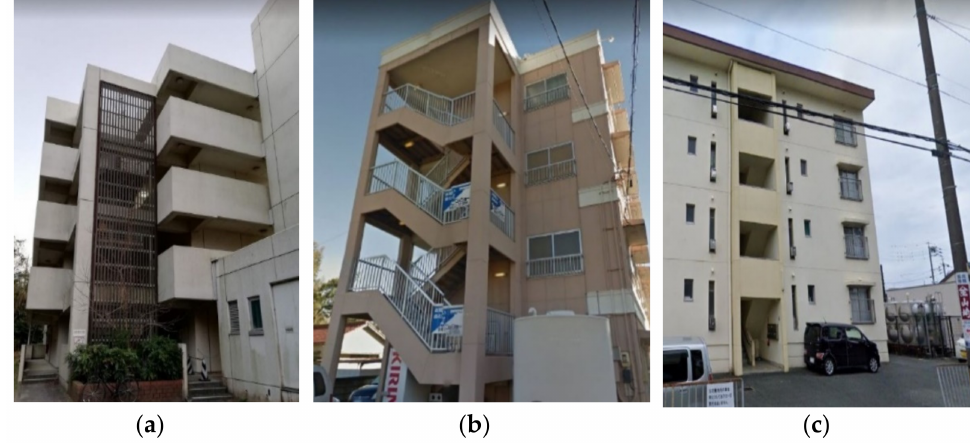
Figure 1. Participants’ house types: ( a ) university dormitory, ( b ) private apartment, and ( c ) public